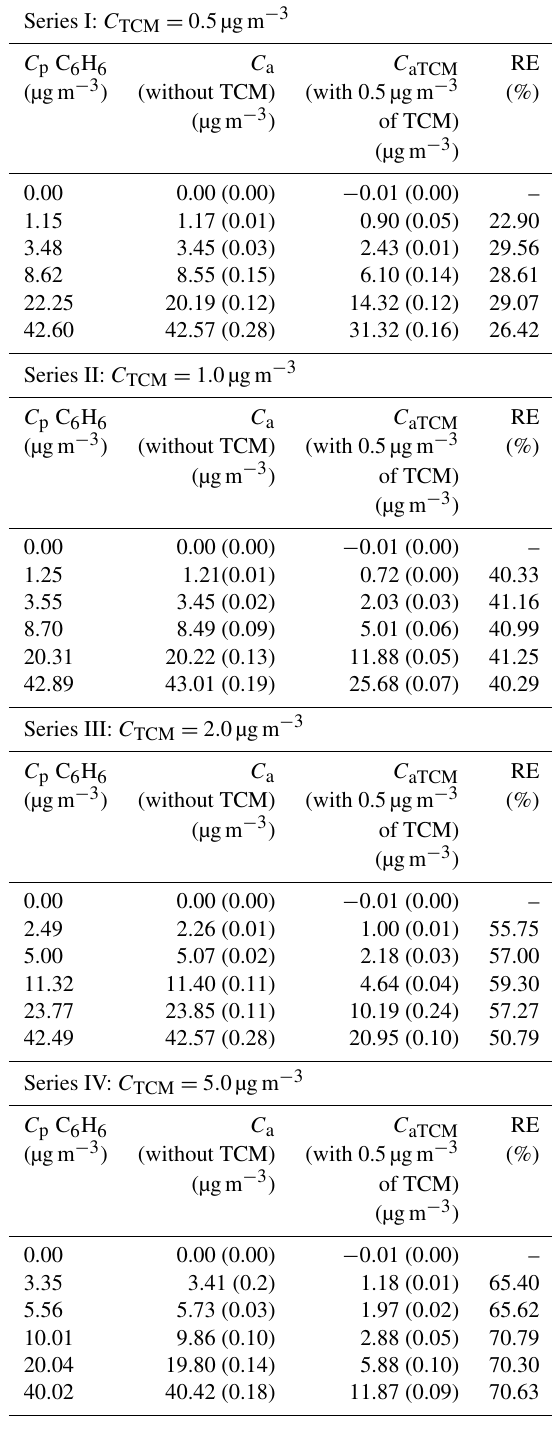
Table 3. Average readings of benzene concentrations obtained with Analyser I when measuring benzene reference gas mixtures with- out TCM ( C a ) and with TCM ( C aTCM ). Standard deviation of six measurements shown in parentheses.